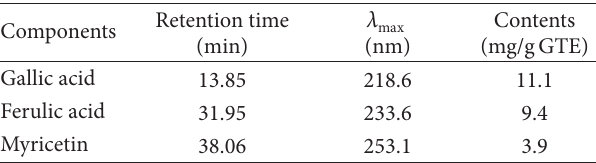
F 1: HPLC chromatograms of the aqueous extract of guava twigs (GTE). T 1: HPLC analysis of the three marker components in the aqueous extract of guava twigs (GTE).